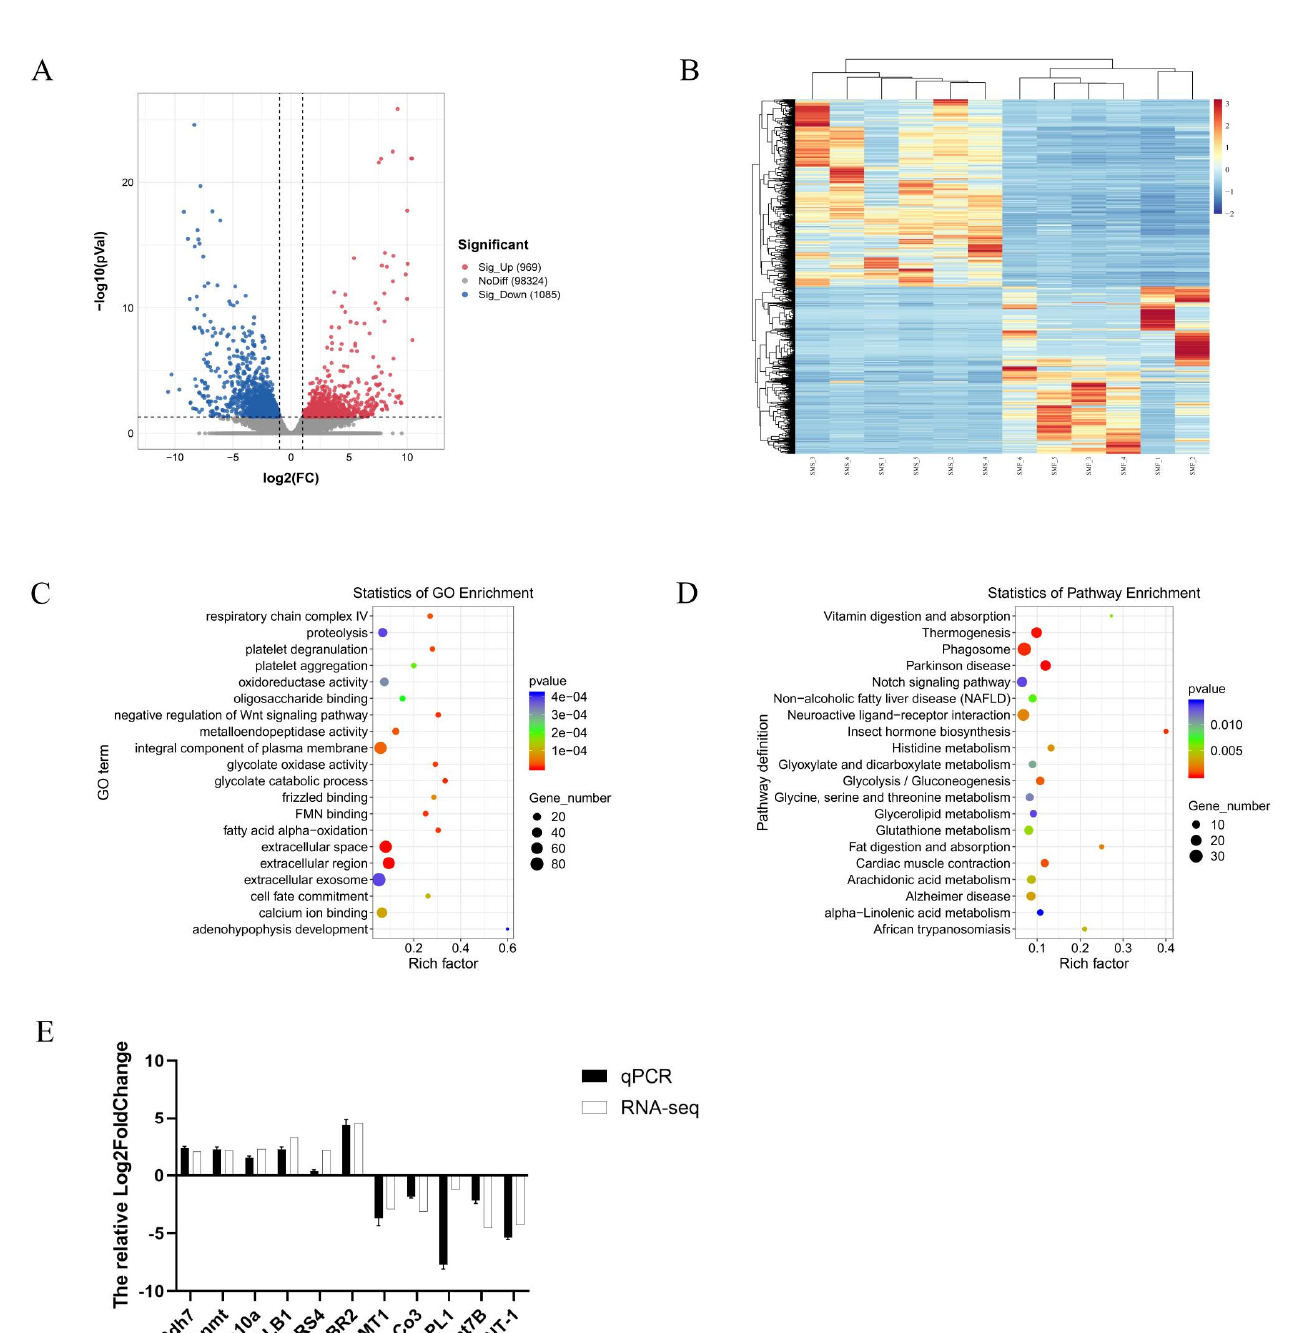
Figure 4. Transcriptome analysis of S. monotuberculatus in the SMF and SMS groups. ( A ) Volcano plot of DEGs between the SMF group and the SMS group. ( B ) The hierarchical clustering analysis of the DEGs between the two groups. ( C ) GO functions of DEGs between the two groups. ( D ) KEGG functions of DEGs between the two groups. ( E ) Comparison of gene expression data from RNA ‐ Seq and qRT ‐ PCR. Data are expressed as the mean ± standard deviation (SD) of three replicates.